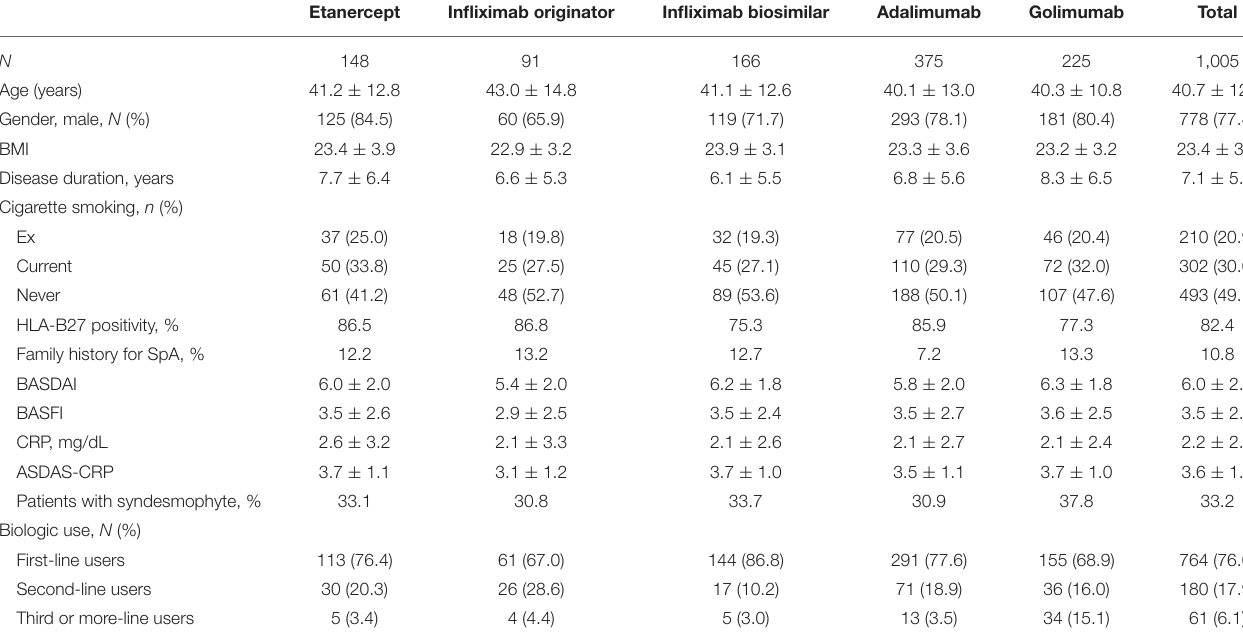
TABLE 1 | Baseline characteristics of the study